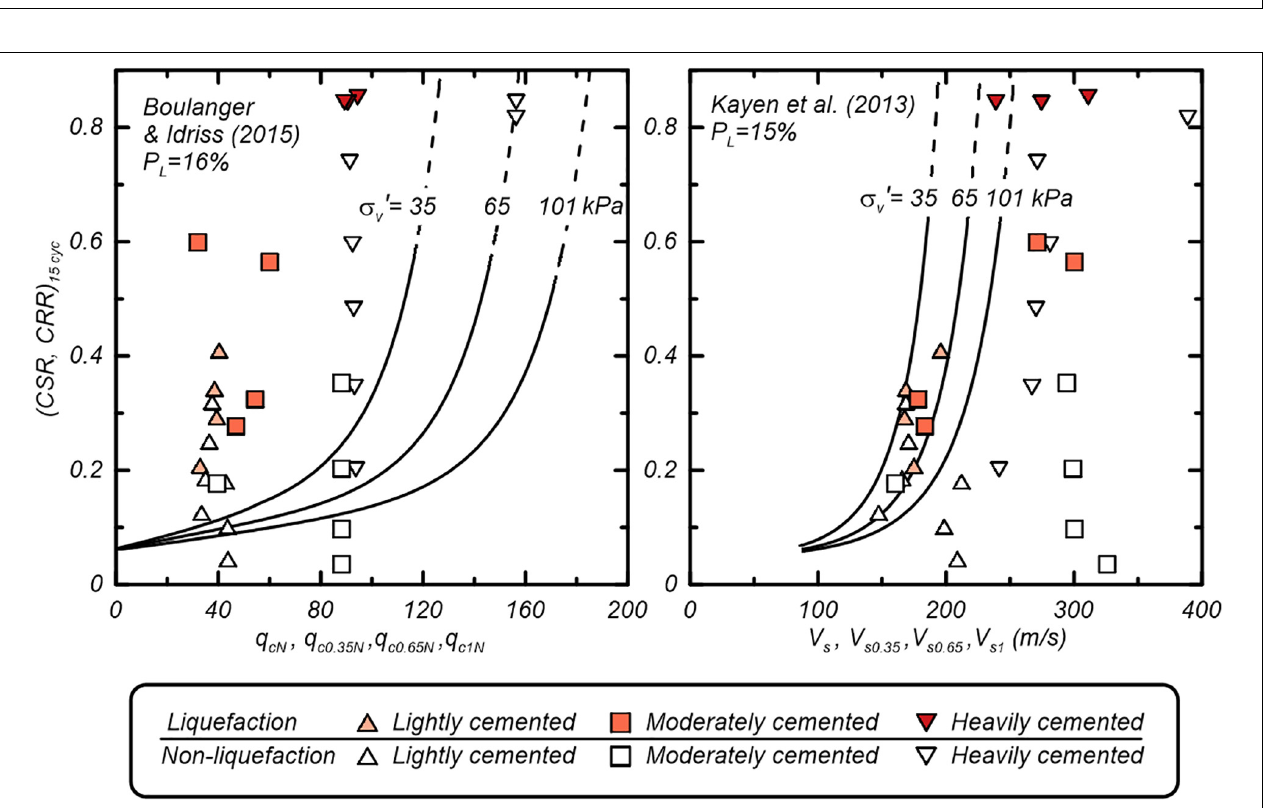
FIGURE 12 | (A) Cone penetration resistance and (B) shear wave velocity at mid-depth in a model on the 1-m radius centrifuge versus the calcium carbonate content produced by MICP treatment (Permission from Darby et al., 2019 with permission from ASCE).